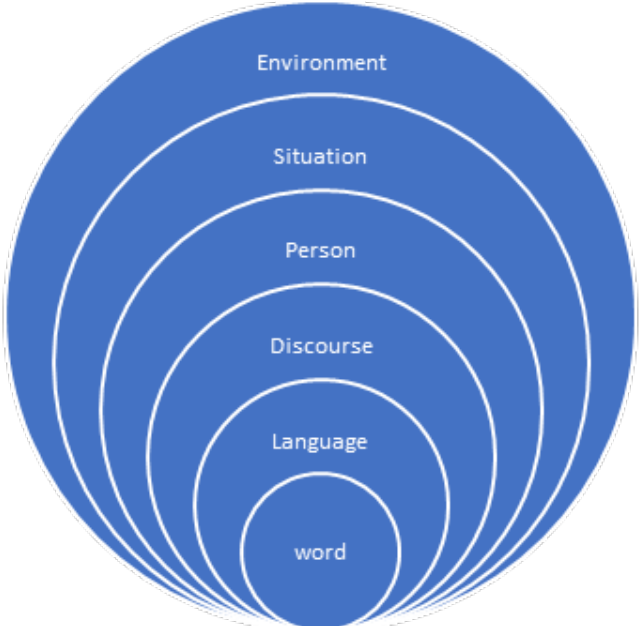
Figure 1. Animal welfare discourse explanatory framework Adapted from [23].